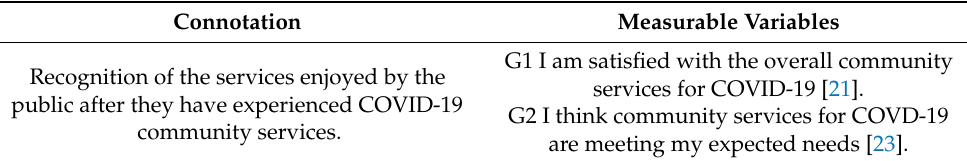
Table 4. Connotation and measurable variables of public